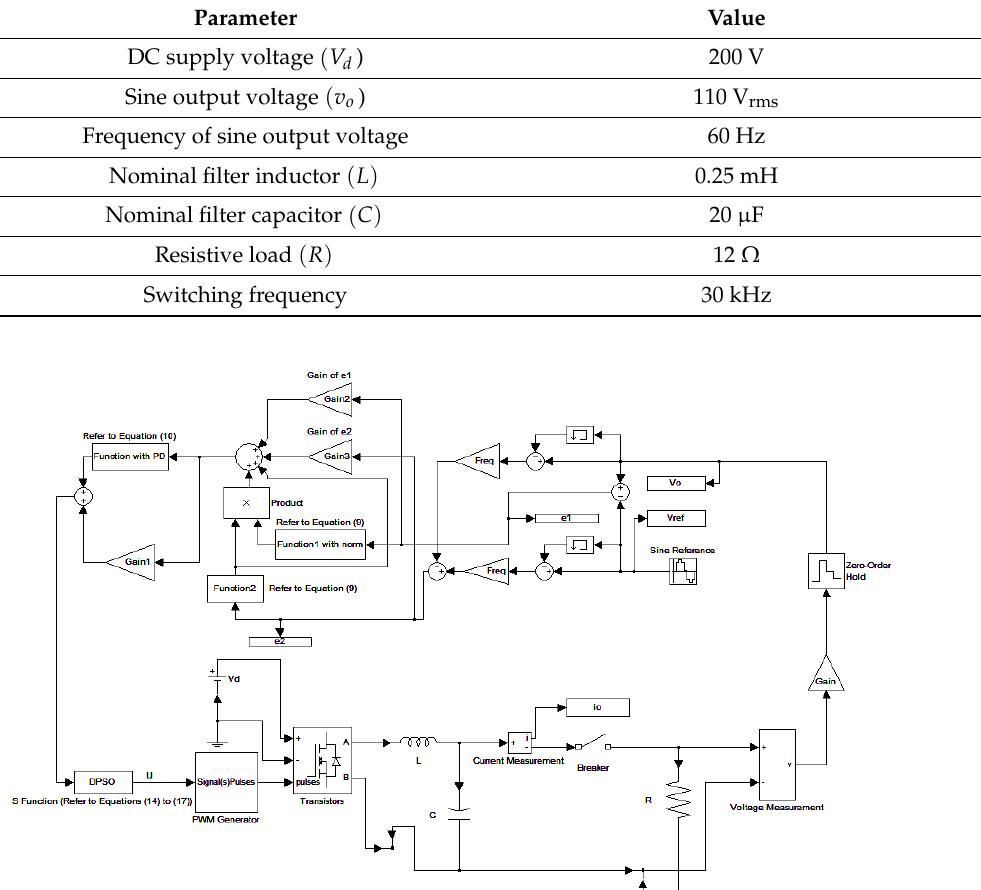
Figure 4. Graphical form of control signal conversion in Simulink/Matlab environment.